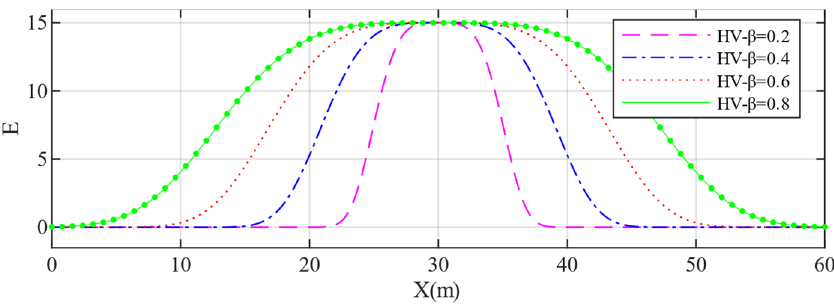
Figure 4. Risk field distribution for OV’s with different aggressiveness values along the X-axis.